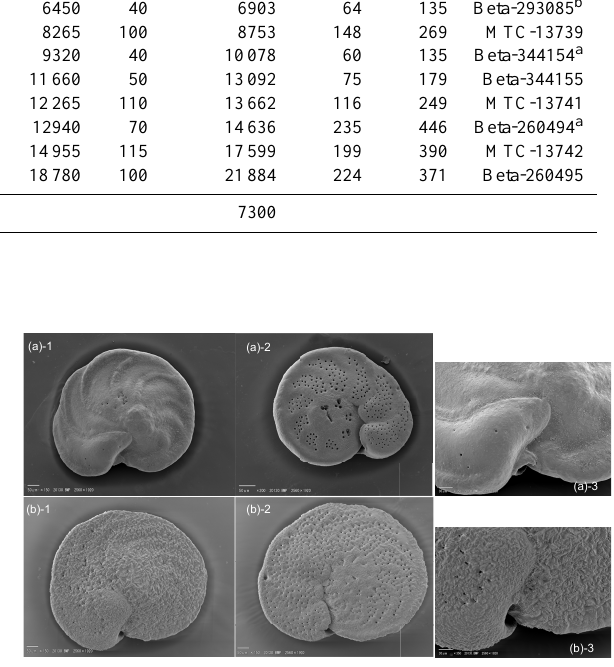
ment compositions were measured for each sample cup.